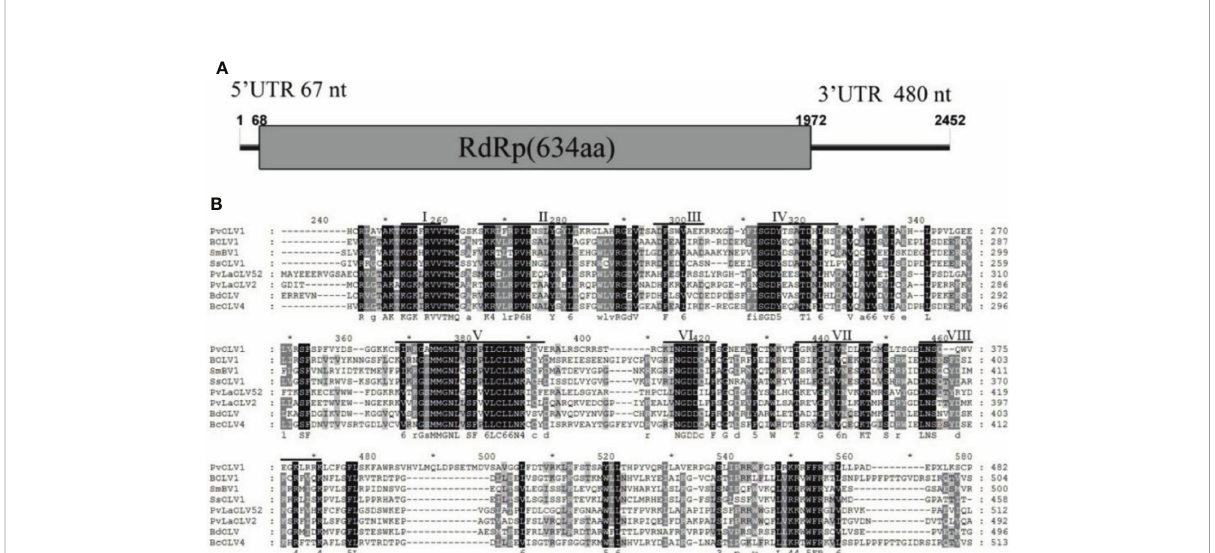
FIGURE 6 Diagrammatic representation of the genome organization and multiple alignment of PvOLV1. (A) Schematic representation of the PvOLV1 genome organization, containing a single open reading frame (ORF) encoding a putative RNA-dependent RNA polymerase (RdRp) and 5 ’ and 3 ’ untranslated regions (UTRs). (B) Multiple alignment of the aa sequences of RdRp domains of PvOLV1 and other similar Botourmiaviridae viruses using the ClustalX program and highlighted using the GeneDoc program. The conserved motifs in these RdRps are indicated by Roman numerals I to VIII. Virus names and accession numbers are as follows: BOLV1, Botrytis ourmia-like virus (QLF49182.1); SmBV1, Sclerotinia minor botoulivirus 1 (QHR78948.1); SsOLV1, Sclerotinia sclerotiorum ourmia-like virus 1 (ALD89138.1); PvLaOLV52, Plasmopara viticola lesion associated ourmia-like virus 52 (QGY72582.1); PvLaOLV2, Plasmopara viticola lesion associated ourmia-like virus 2 (QGY72532.1); BdOLV, Botryosphaeria dothidea ourmia-like virus (QED22728.1); BcOLV4, Botrytis cinerea ourmia-like virus 4 (QJT73670.1).